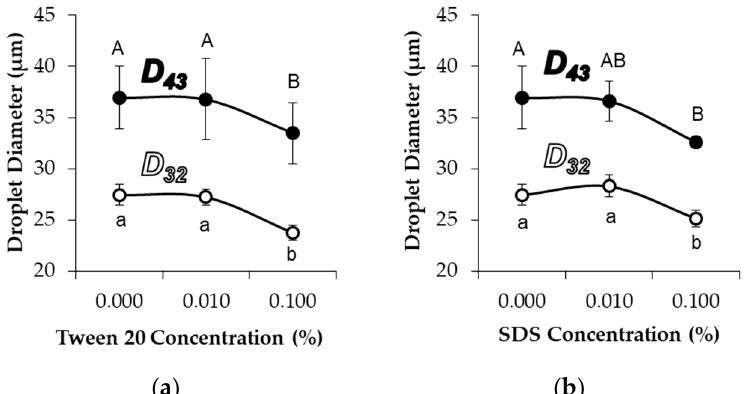
Figure 5. Effect of Tween 20 ( a ) and SDS ( b ) addition on moment-based mean droplet diameters of MG 58 emulsions. Uppercase/lowercase letters above/below datapoints denote groups of D 43 /D 32 data that were not significantly different as a function of surfactant concentration.